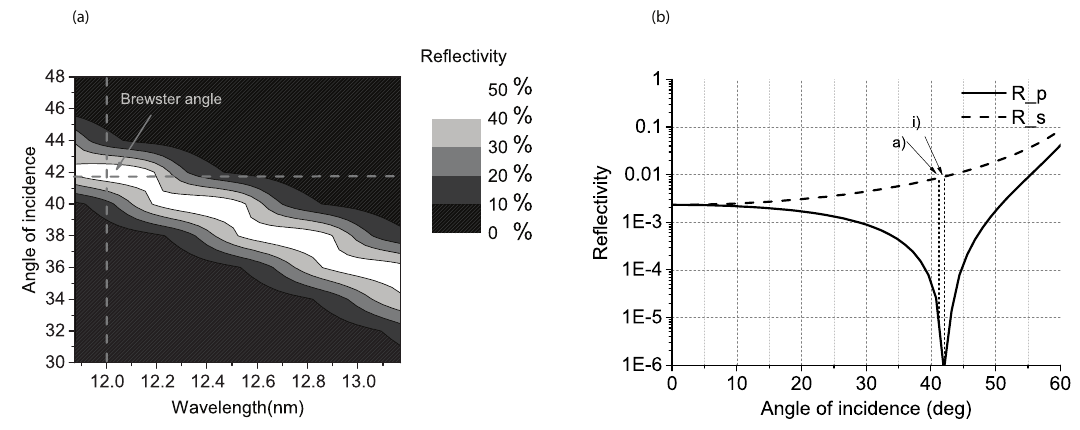
Figure 9. ( a ) Angle of incidence on the polarizer mirrors versus wavelength. The maximum reflectivity is approximately 50% for each wavelength for a specific angle of incidence. ( b ) Reflectivity versus incident angle (parallel, R (dashed line), and perpendicular, R s p (continuous line)) on the EUV range. (a) and (i) refer to Figure 8. The reflectivity